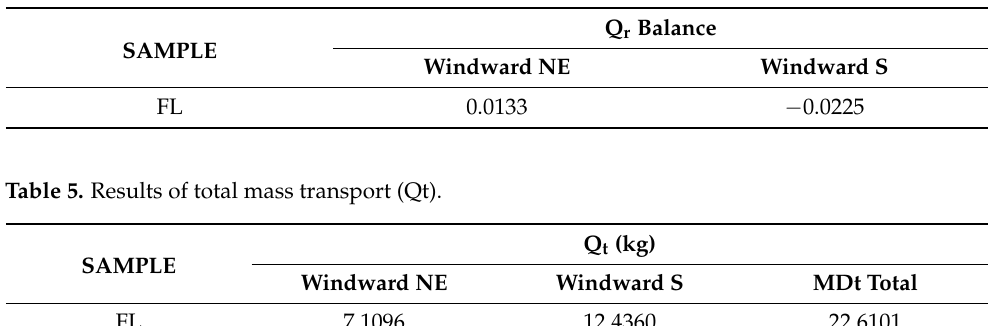
Table 4. Results of sediment transport rate (Q r ) balance.